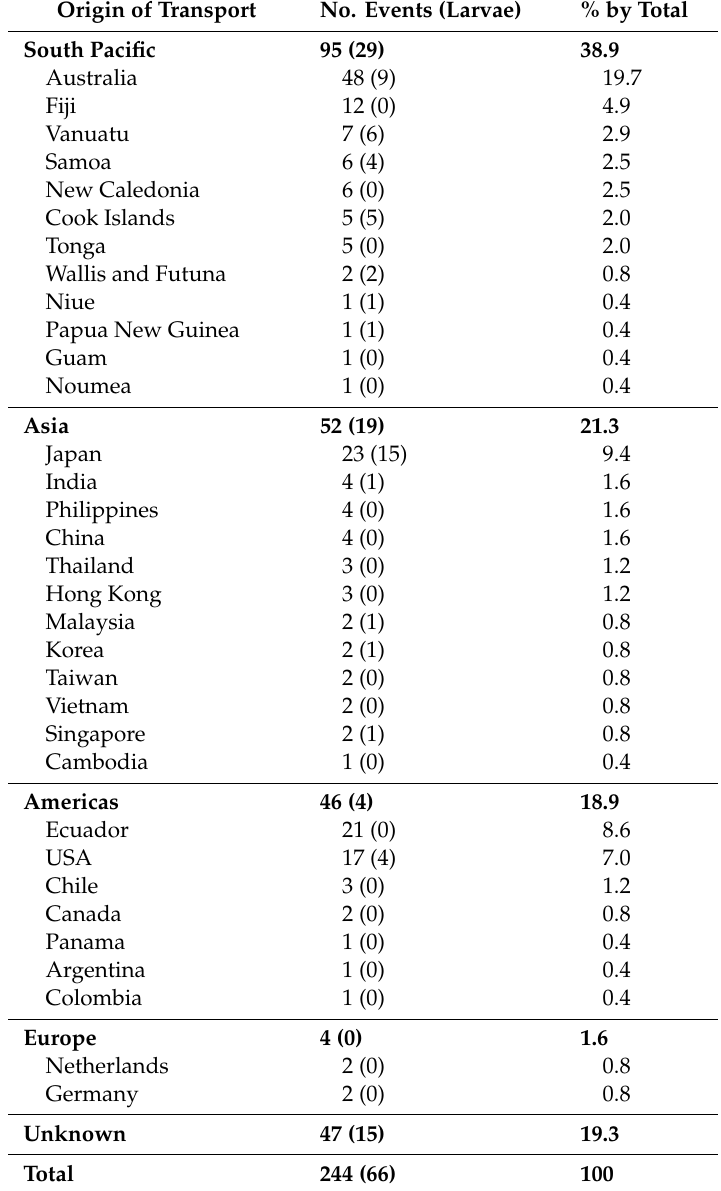
Table 2. Countries of origin and development stages of mosquito interception events in New Zealand, July 2001–March